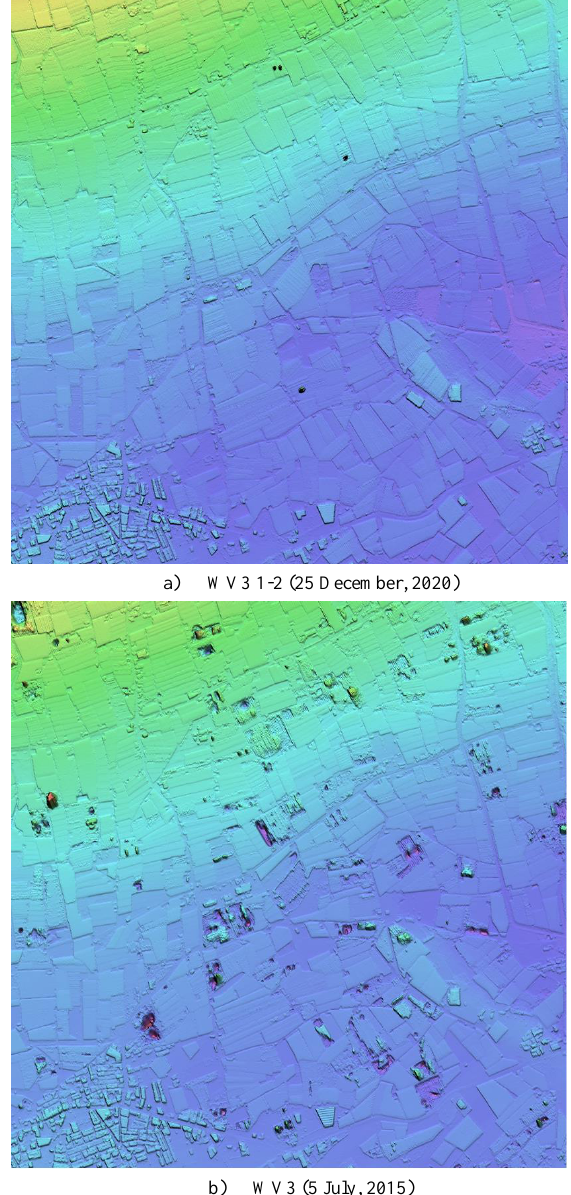
Table 3. Vertical accuracy measures of DSMs derived from stereo pairs and triplet (MultiView, MV) for each land cover. Figure 7. DSM from WV3 stereo pairs over a square area of 2,500 m x 2,500 m: a) WV3 stereo pair 1-2 taken on 25 December, 2020; b) WV3 stereo pair taken on 5 July, 2015 and used by Aguilar et al.